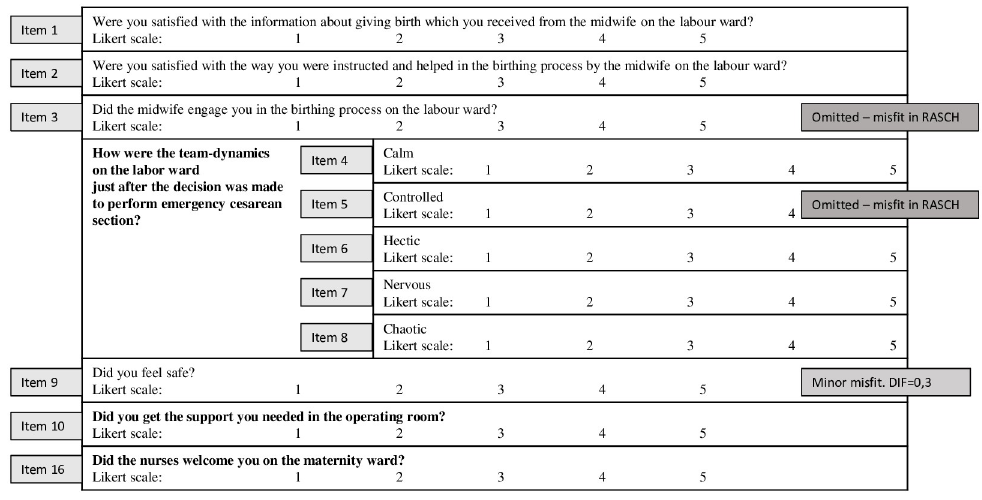
Fig 3. Partners´ questionnaire. Likert scale is a visual analog scale that measures subjective characteristics. The Likert items state the level of disagreement = 1; agreement = 5. Misfit: Rasch analysis is a statistical methodology that tests if the observed item scores are consistent with measurement requirements. If this is not the case, there is a misfit. If the misfit is high, the questionnaire item is omitted (left out).